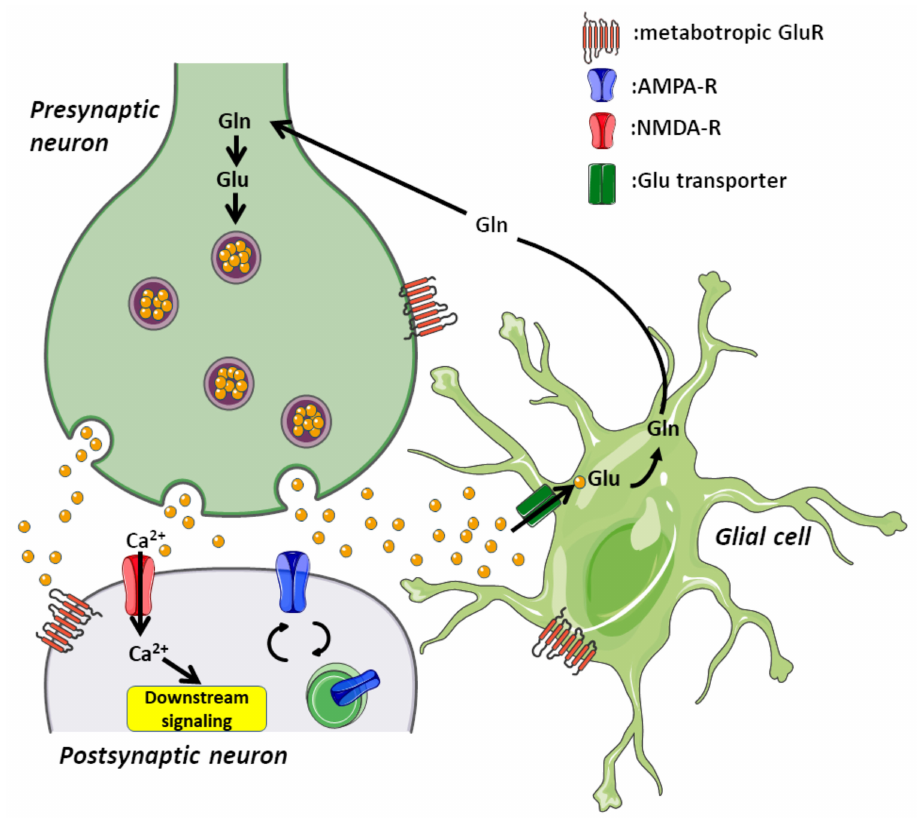
Figure 1. Excitatory synapse structure. Excitatory synapses are the most common in the central nervous